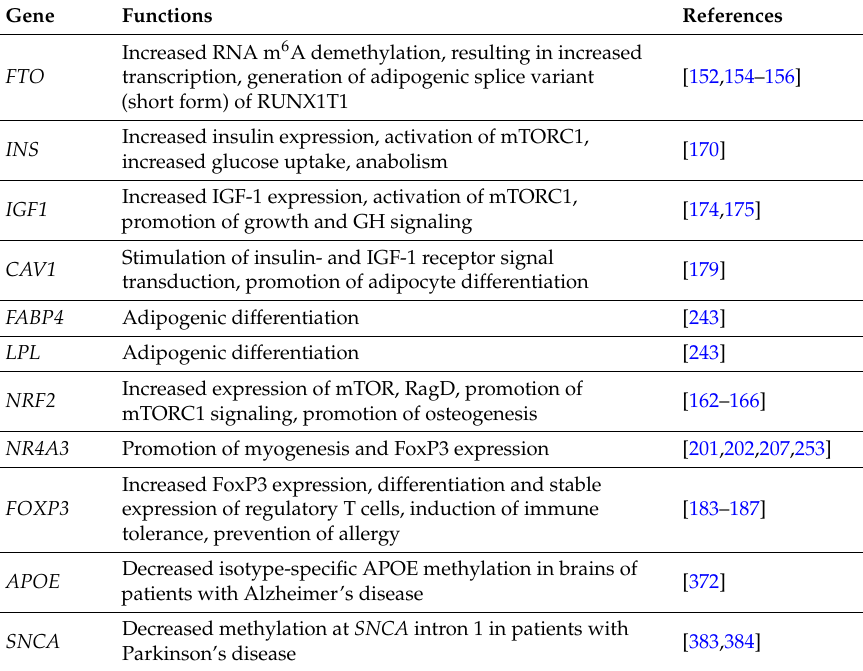
Table 5. Genes with increased DNA CpG demethylation-dependent